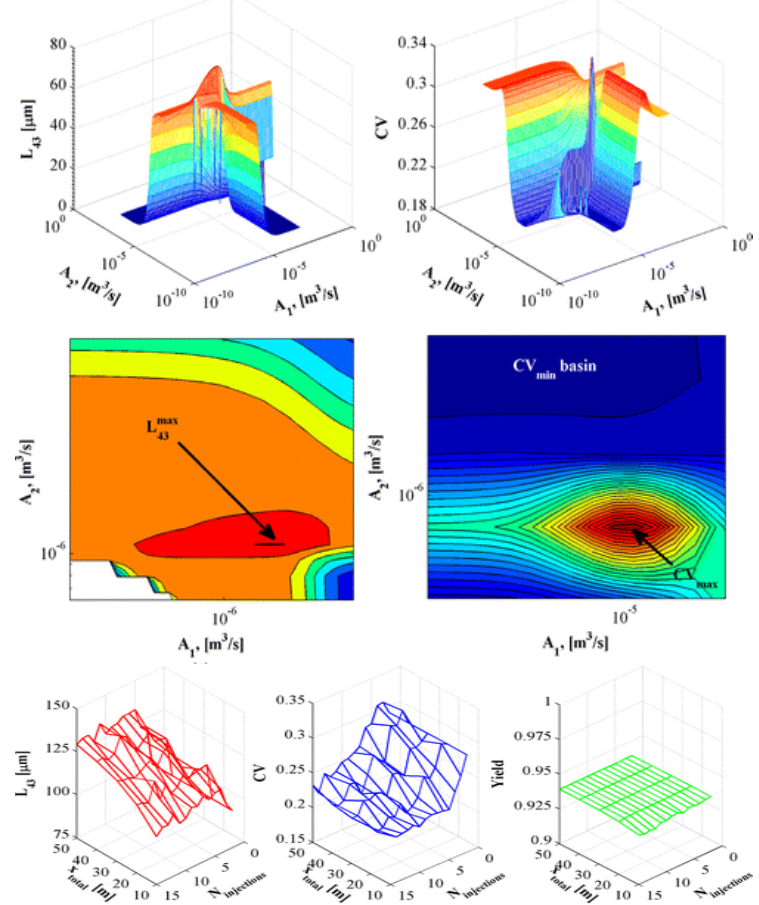
Figure 6. Design space of crystal quality (average size + size distribution coefficient of variation) vs. antisolvent addition at di ff erent inlets. Reproduced with permission from Ridder et al., Industrial & Engineering Chemistry Research; published by American Chemical Society, 2014